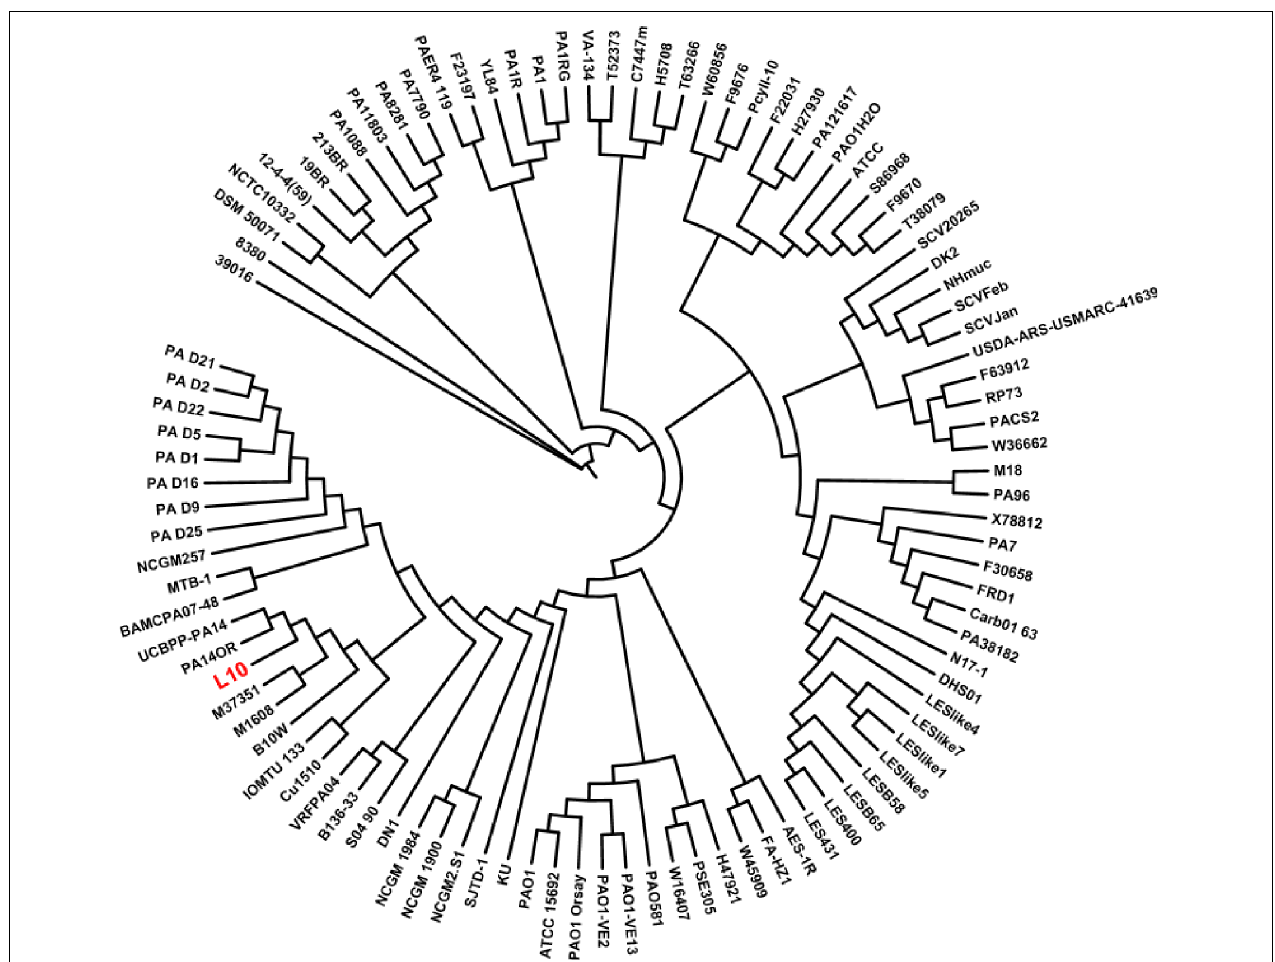
FIGURE 6 | Phylogeny based on core SNPs of 101 strains of P. aeruginosa . We constructed the phylogenetic tree using kSNP3.0, and visualized it using iTOL. P. aeruginosa L10 is highlighted in